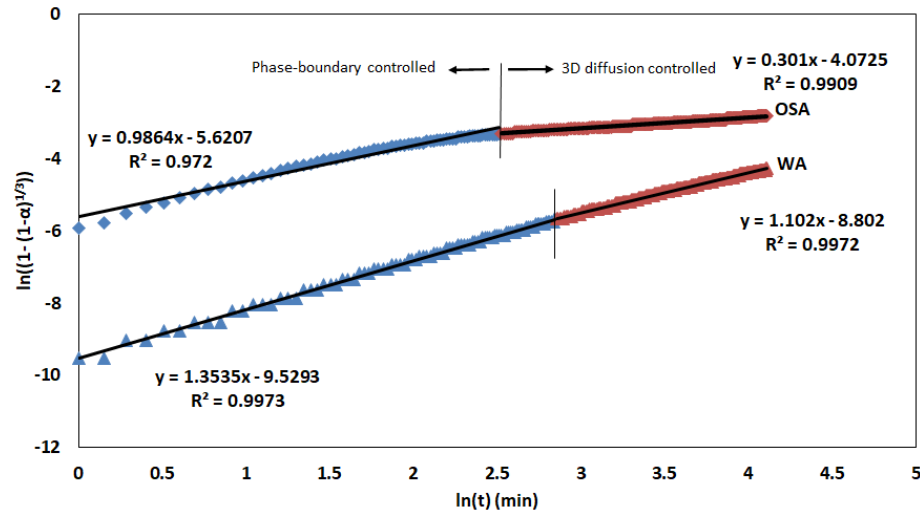
Figure 17. Evaluation of carbonation kinetics: ln(1 − (1 − α) 1/3 ) versus ln(t) for OSA and WA carbonation (R 2 = correlation coefficient).